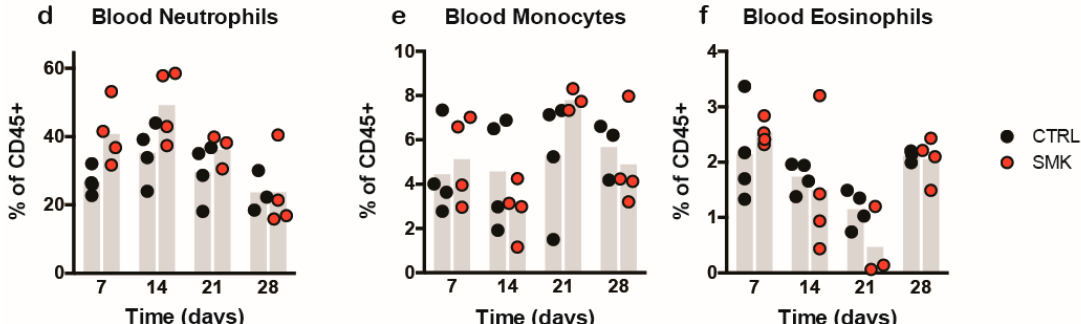
Figure 6. Leukocyte analysis in bone marrow and blood of SJL/J mice revealed a small but not significant increase in blood neutrophils of SMK mice at days 7 and 14 after immunization. Percentage of leukocyte subsets in bone marrow (BM) ( a – c ) and blood ( d – f ) were analyzed using 4-color flow cytometry gating of total leukocytes (CD45 + ). The subsets were identified as neutrophils (CD11b + Ly6G + ), monocytes (CD115 + ), and B cells (CD19 + ). A transient, but not statistically significant, increase in the percentage of peripheral neutrophils in SMK mice compared to CTRL is noted at days 7 and 14 post immunization ( d ).